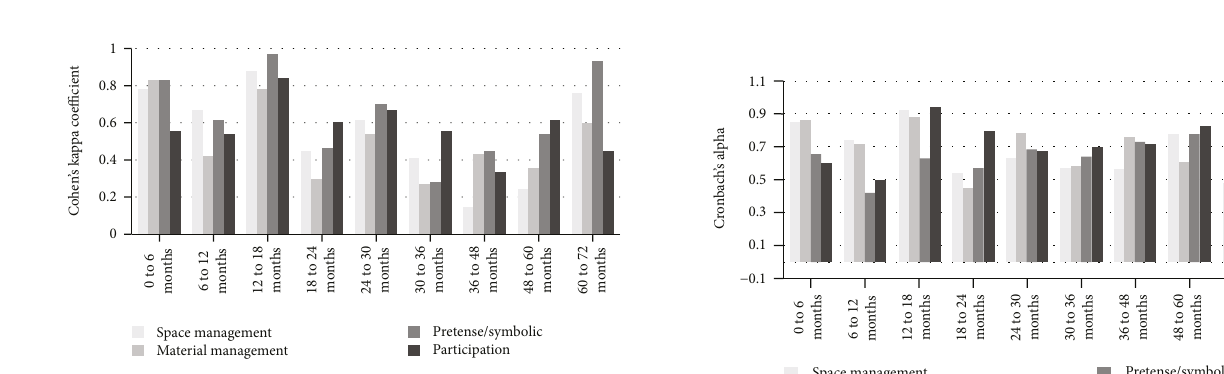
Figure 2: Intrarater agreement for the rater 2.